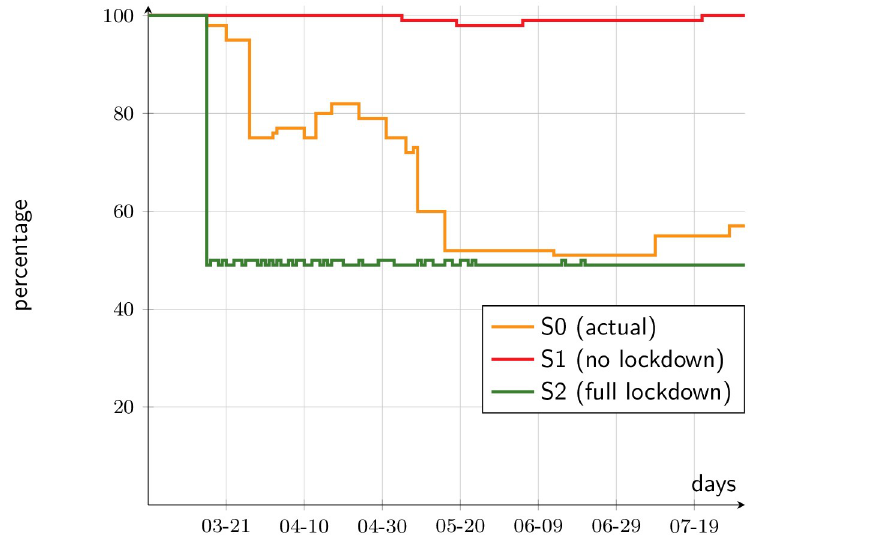
Fig 11. Material welfare index, without aid (percentage of